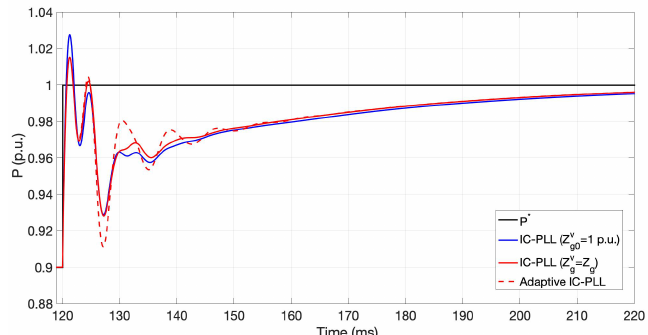
Figure 9. Time-domain response of the active power for different types of PLLs for step change in active power and for ω FL , PLL = 400 rad/s, Z g = 1.1 p.u. (inverter operation).